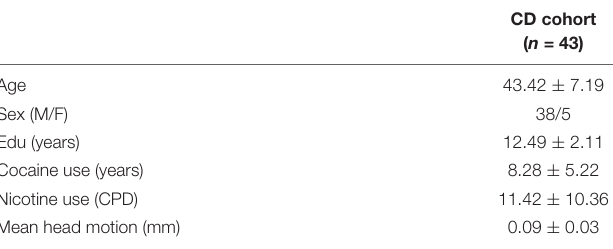
TABLE 1 | Demographic, clinical and head-motion